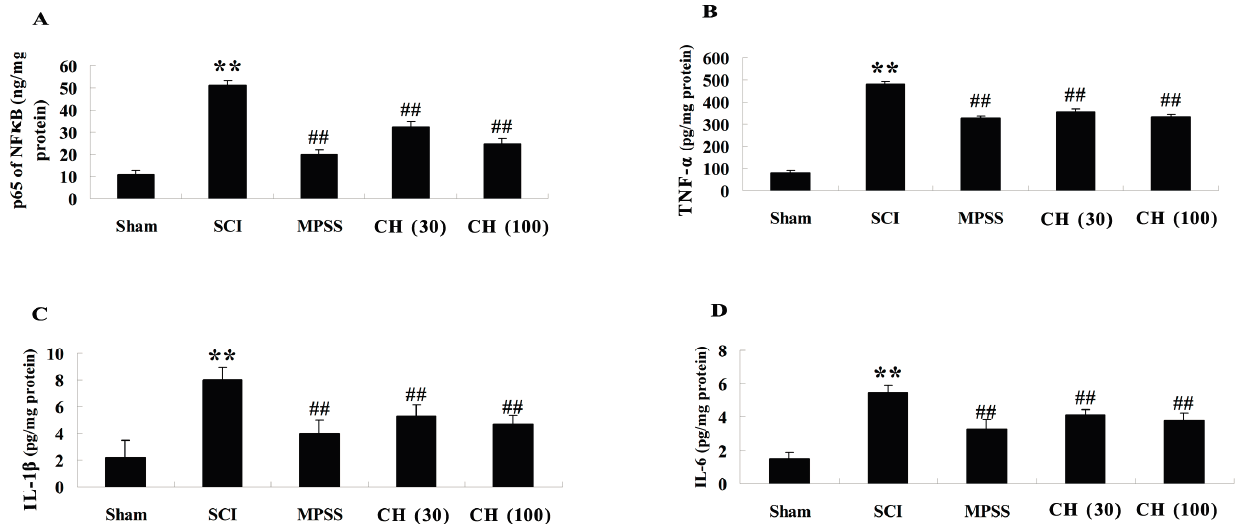
Figure 3. CH inhibits the levels of the NF κ B p65 subunit ( A ); TNF- α ( B ); IL-1 β ( C ) and IL-6 ( D ) after SCI ( n = 10, mean ± SD). ** p < 0.01 compared with the sham group; ## p < 0.01 compared with the SCI group. Sham, sham group; SCI, spinal cord injury group; MPSS, methylprednisolone-treated; CH (30), chrysin (30 mg/kg)-treated; CH (100), chrysin (100 mg/kg)-treated